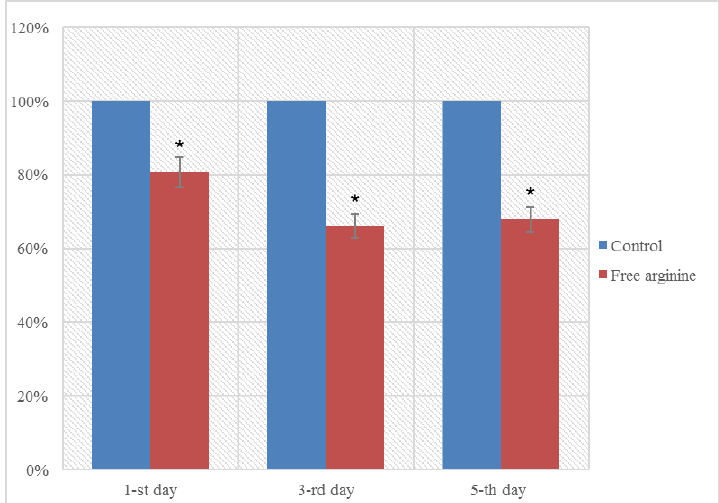
Fig. 3. The level of free arginine in the blood in adrenaline-induced myocardial injury under immobilization stress (in % of control): * – p<0.05 compared to the indicator in the control